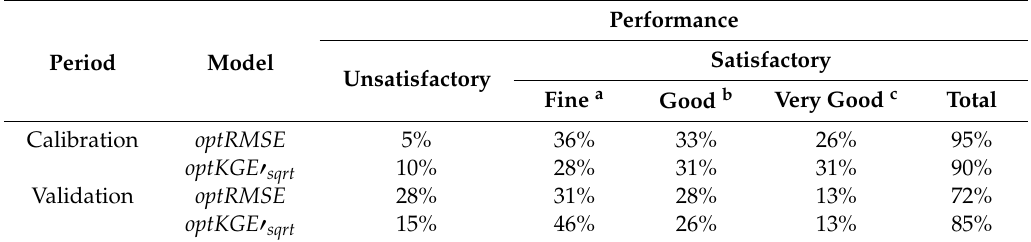
Table 3. Performance comparison of the 3-Tank model calibrated with the two objective functions ( optRMSE and optKGE (cid:48) sqrt ) for the 39 study